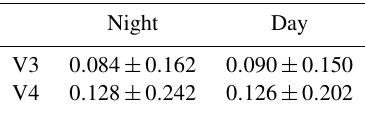
Table 5. Mean column AODs ( ± standard deviation) for CALIOP V3 and V4, computed from aerosol extinction profiles, for all-sky conditions from 2007 to 2009. Profiles in which either V3 or V4 contained aerosol layers are included in the